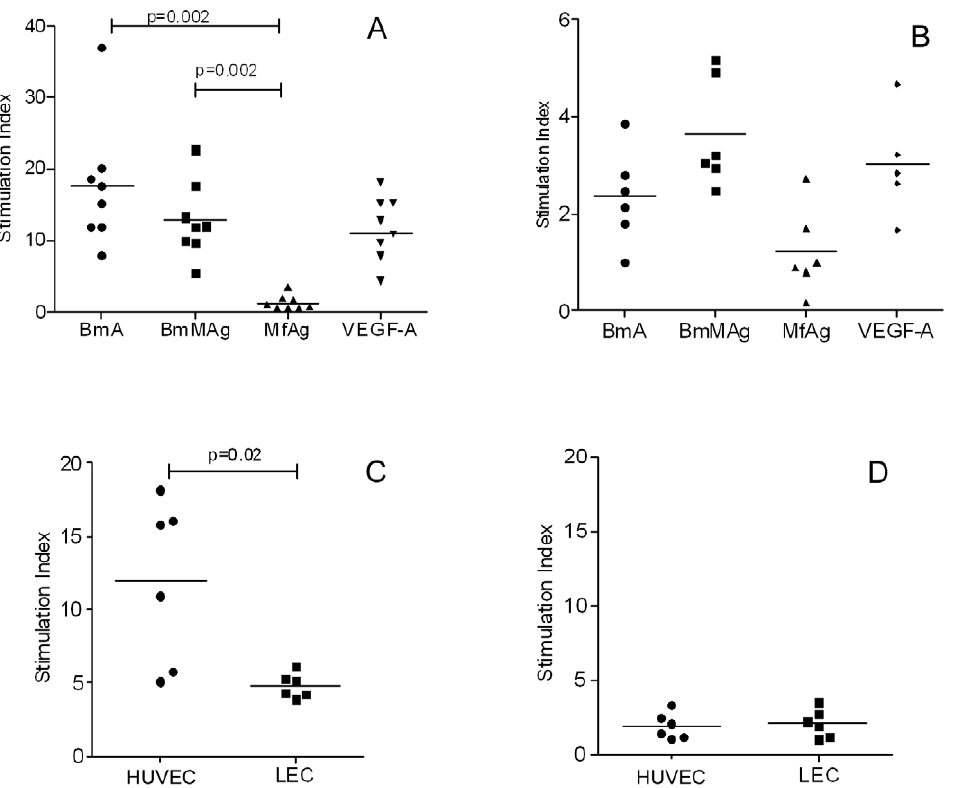
Figure 1. Filarial antigen-induced proliferation. LEC at 5 6 10 3 were seeded in 96-well tissue culture plates in endothelial basal media and stimulated with optimized concentrations (10 m g/ml) of BmA, BmMAg, MfAg, and VEGF (25 ng/ml or 10ng/ml). Data are expressed as stimulation index over the unstimulated controls for each set of cultures and the horizontal bar is the geometric mean. Panels A and B show the response of LEC (Panel A) and HUVEC (Panel B) to the stimuli shown on the x-axis. Panels C and D show the proliferative effect on HUVEC and LEC of schistosome egg antigen (SEA Panel C) and of schistosome adult antigen (SWAP Panel D).